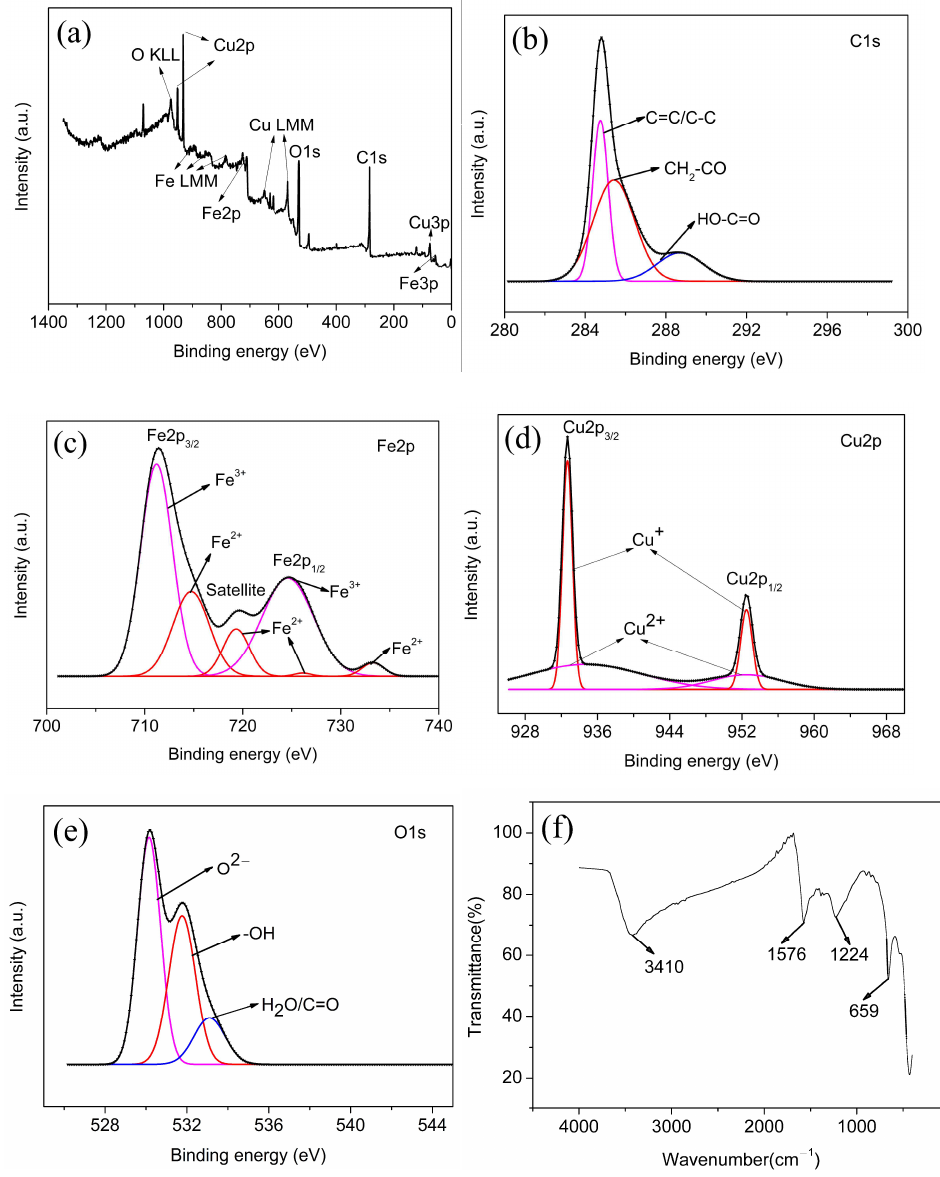
Figure 5. ( a ) XPS spectra; ( b ) C 1s spectra; ( c ) Fe 2p spectra; ( d ) Cu 2p spectra; ( e ) O 1s spectra; and ( f ) FTIR.